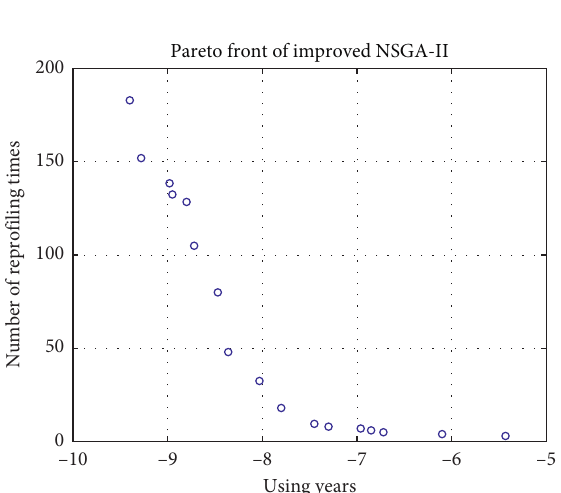
Figure 12: NSGA-II strategy.